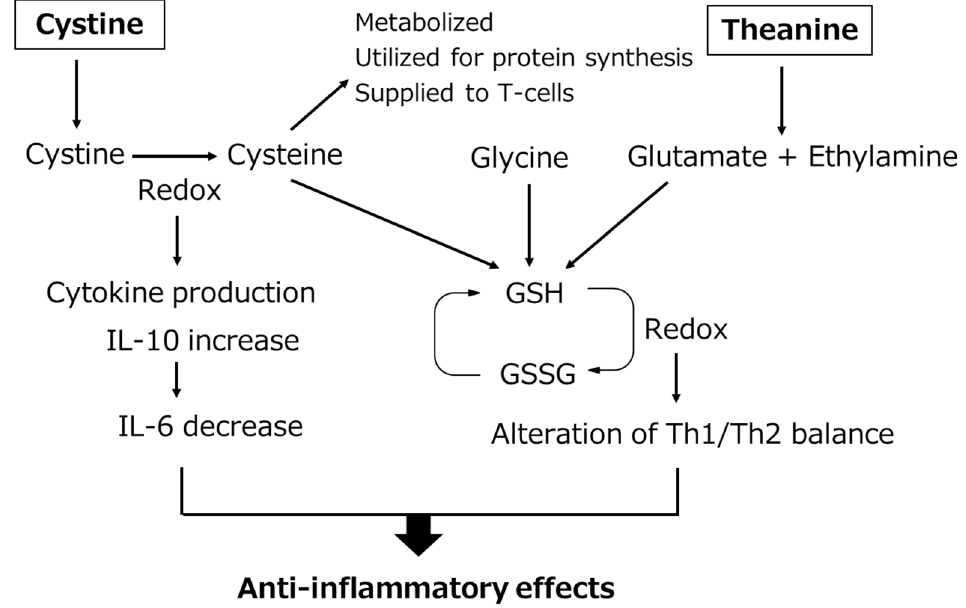
Figure 3. Working hypothesis for the anti-inflammatory effects of cystine/theanine. Cystine/theanine have anti-inflammatory effects both through the maintenance of GSH levels and the promotion of IL-10 production. GSH: glutathione, GSSG: glutathione disulfide, IL-10: interleukin-10, IL-6: interleukin-6, Th1/Th2: type 1 helper T cells/type 2 helper T cells.